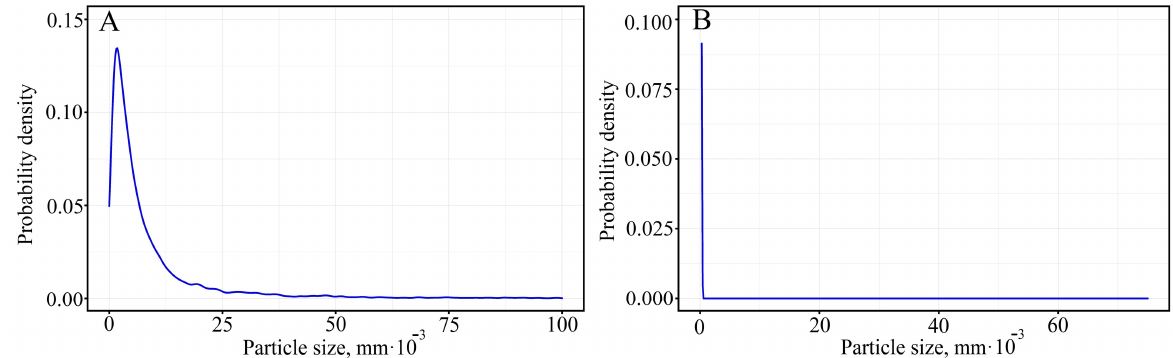
Figure 5. Probability density function of alumina particle size distribution in 3D printed